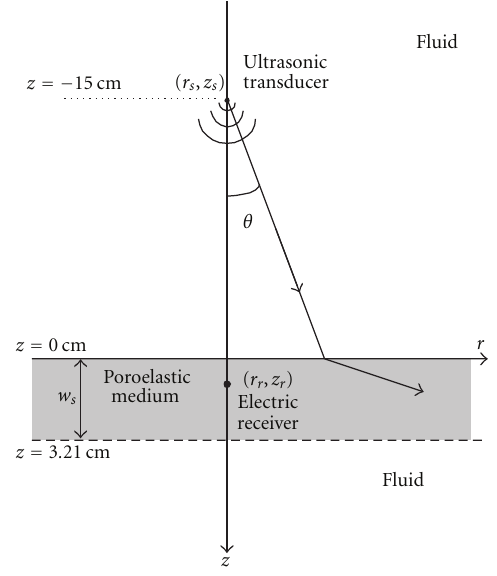
Figure 9: (Modified from [44].) Geometry of seismoelectric model and experiment. An acoustic wavefield emitted from ( r s , z s ) transmits into the poroelastic medium at z = 0, where it generates coseismic electric potentials. Fluid/poroelastic-medium interfaces are at z = 0 and z = 3 . 21 cm. The electric receiver is at 1 cm from the front interface, while the dominant wavelength of the fast P -wave is roughly 4 mm. The electric potential recordings of the electric receiver are with respect to ground